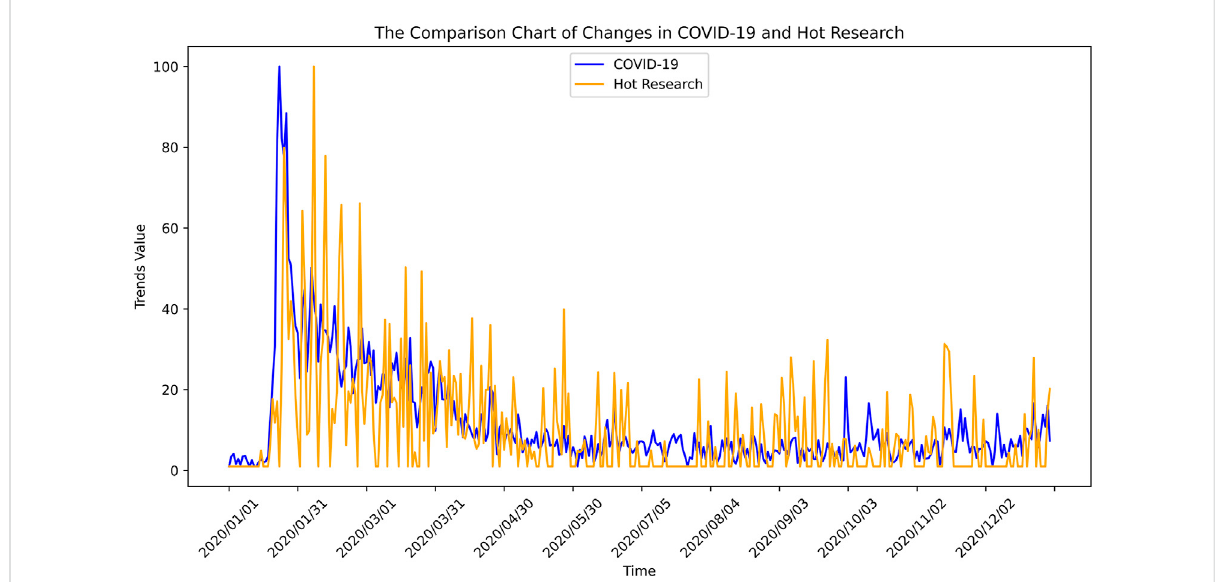
FIGURE 2 The comparison chart of changes in the attention of COVID-19 and hot research.